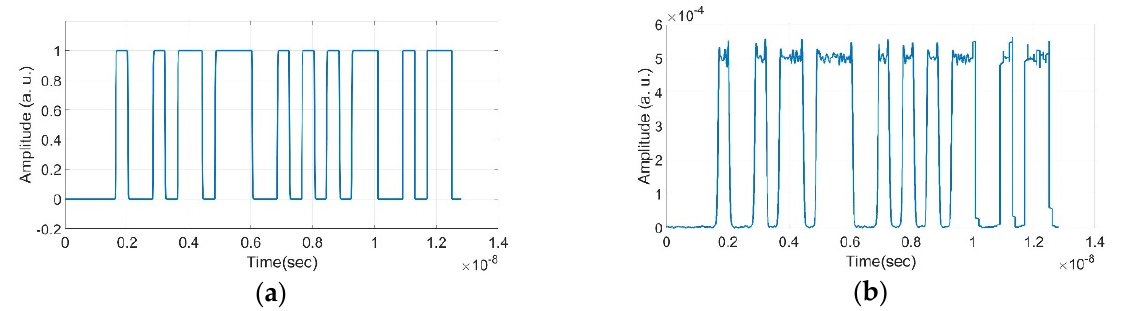
Figure 5. ( a ) The waveform of the transmitted bits. ( b ) Electrical data delivered by the